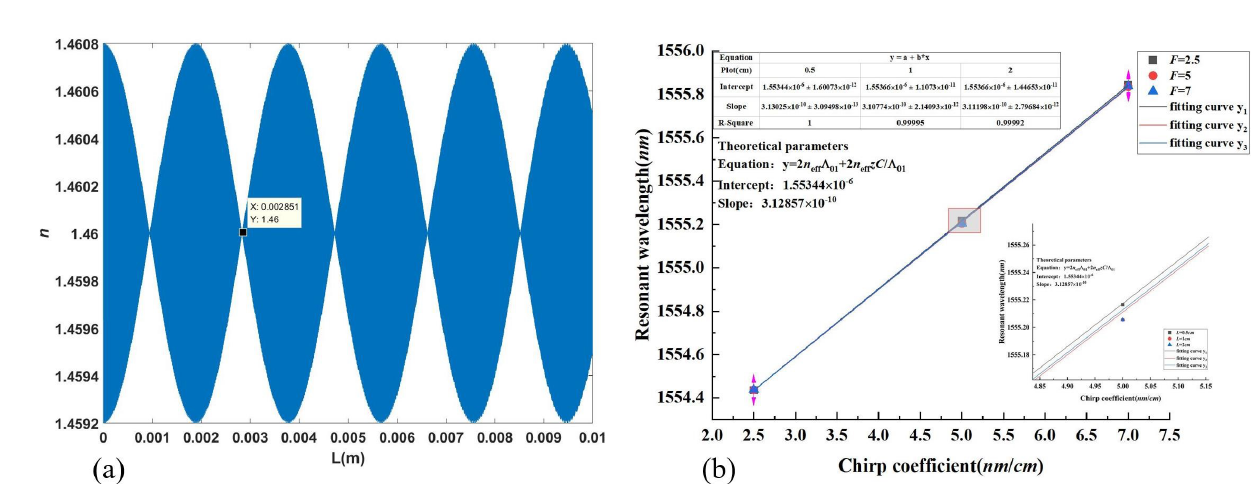
Figure 5. Influence of the chirp coefficient on the resonance wavelength. ( a ) Refractive index distribution of the 2D chirped fiber grating for L = 1 cm; ( b ) Second resonance wavelength at different chirp coefficients for L = 1 cm.